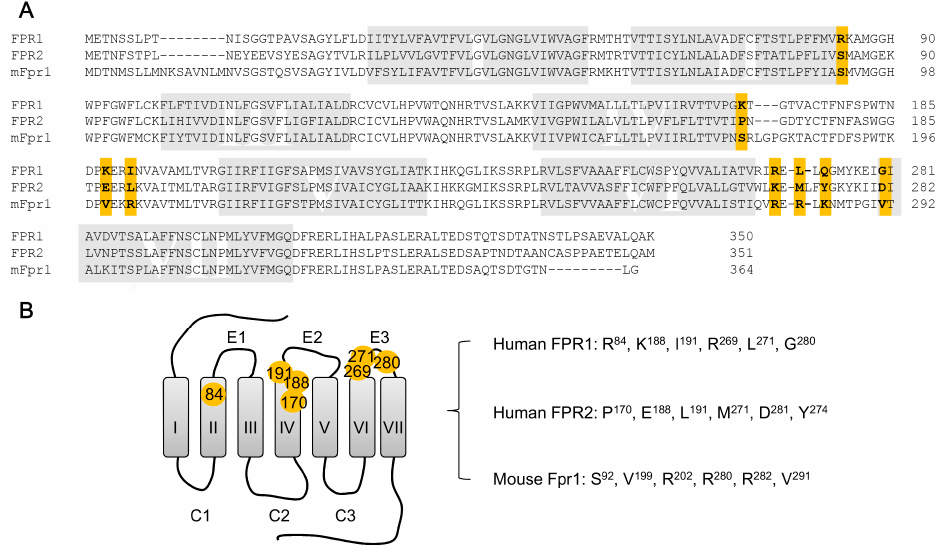
Figure 1. Sequence alignment and location of positive selection sites in human formyl peptide receptors (FPRs): FPR1, FPR2 and mouse mFpr1. ( A ) Alignment of the protein sequence of human FPR1, FPR2 and mouse Fpr1. Positively selected amino acid sites [14] in three FPR isoforms are shown in color; ( B ) Schematic diagram for the location of the positive selection sites in the formyl peptide receptors, based on the sequence of human FPR1. The amino acids at these positions in each of the three receptors are marked on the right.